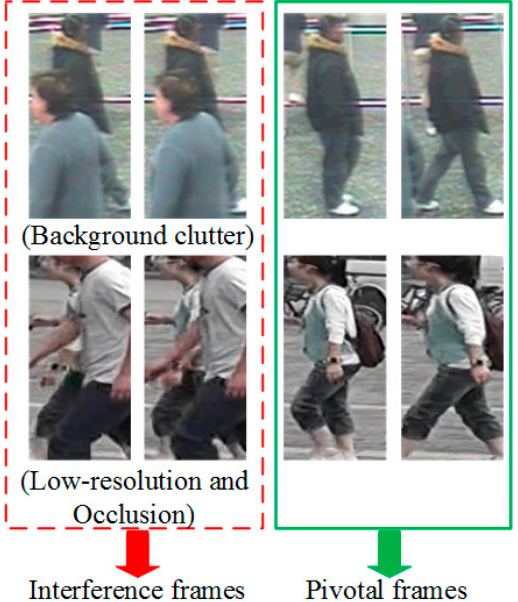
Figure 1. An illustration of the interference frames and pivotal frames definition. The green box indicates the pivotal frame (“good” frame).The red dotted box indicates the interference frame with low-resolution image, occlusion, and background clutter.